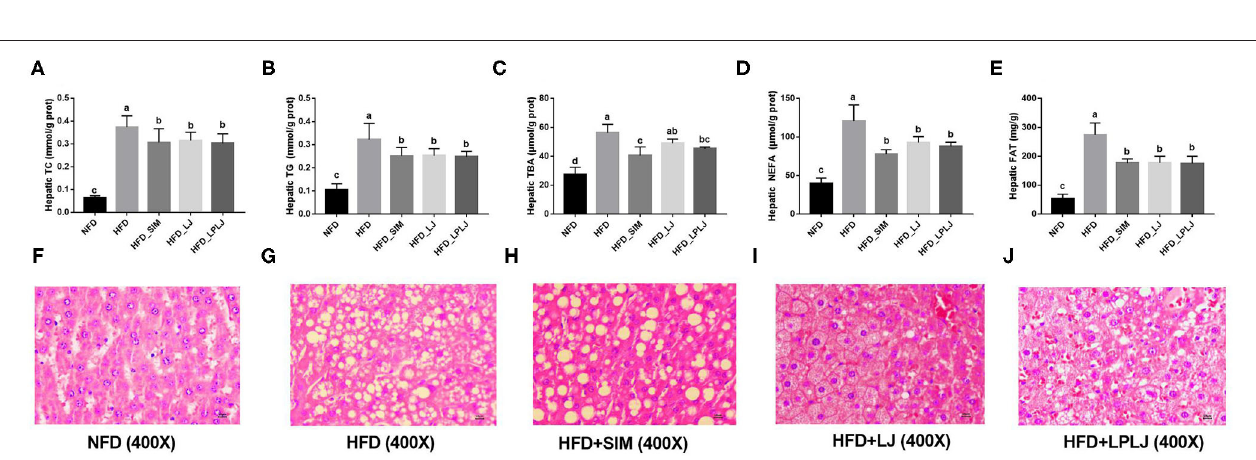
FIGURE 3 | Effects of LPLJ consumption on the liver biochemical parameters and histopathology in rats fed a high-fat diet for consecutive 8 weeks. (A) hepatic TC, (B) hepatic TG, (C) hepatic TBA, (D) hepatic NEFA, (E) hepatic FAT, and (F–J) liver morphology (magnification × 400) in rats fed a high fat diet. a-d, Mean values with different letters in the same column differ significantly ( p <